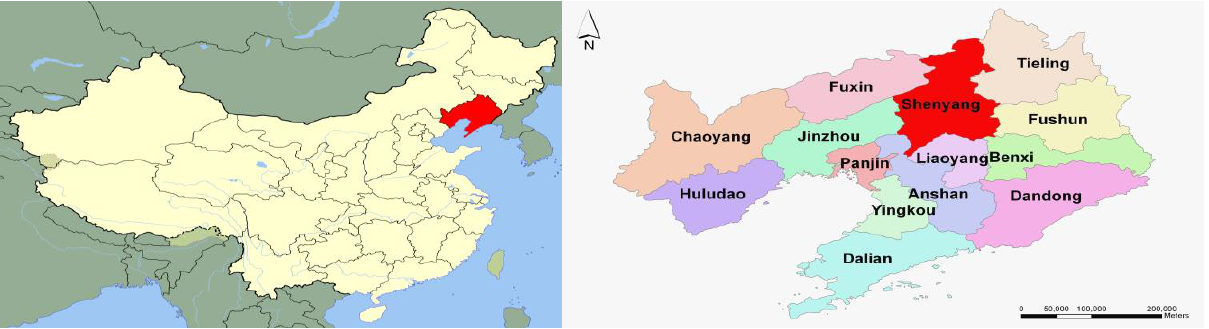
Figure 1. The Liaoning Province study